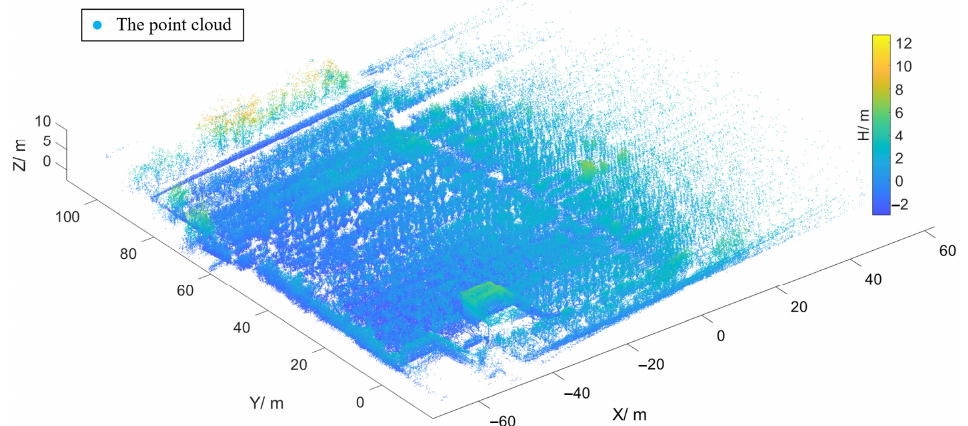
corrected geoid position parameters. Figure 12.